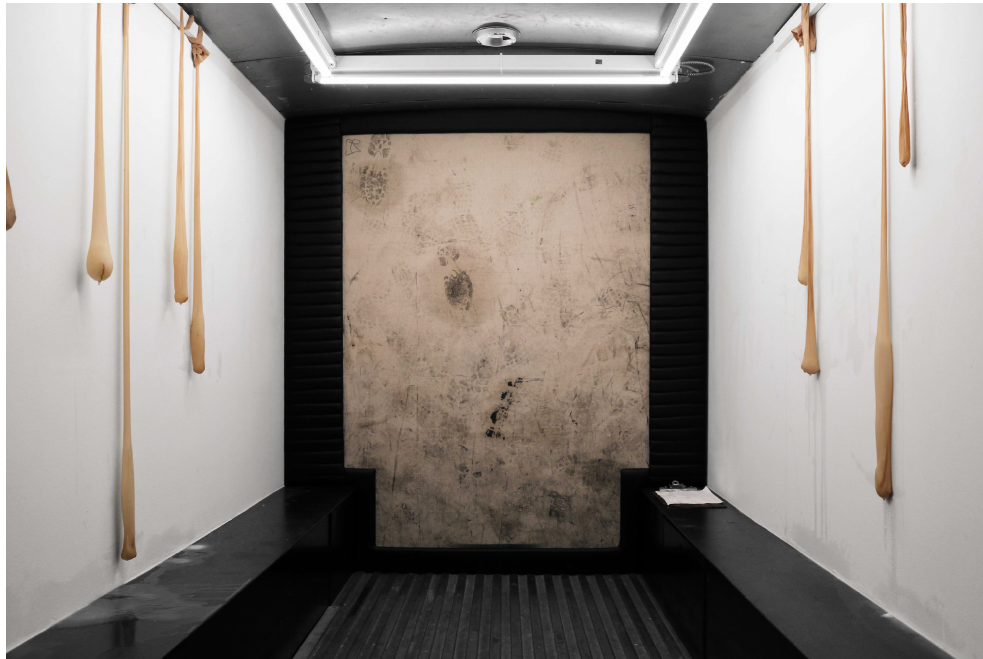
Figure 9: Oil rituals for the future #6 installation view. Photo: Andy Bennett and Colleen Hargaden. Reproduced with permission.